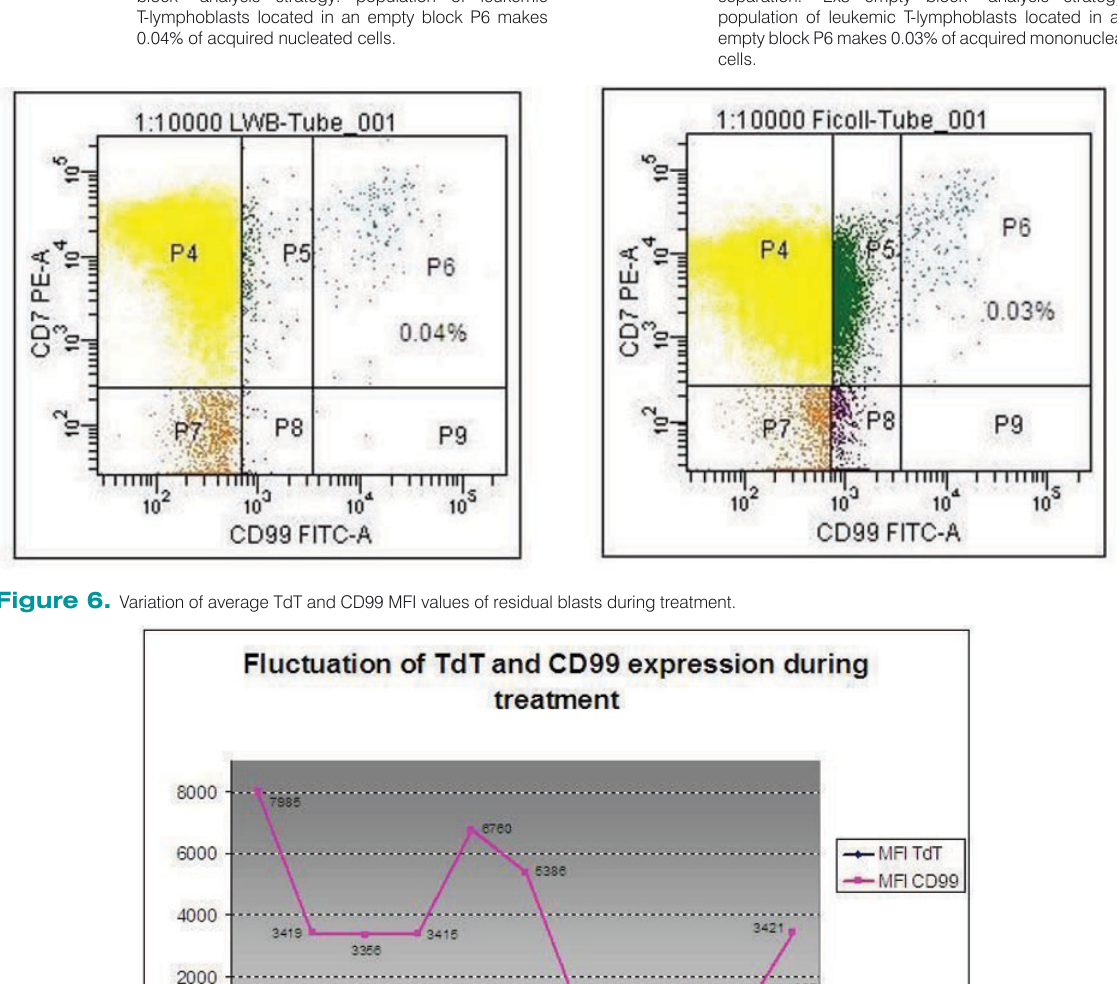
Figure 5a. T-ALL dilution 1:10 000, lysed whole blood. “2x3 empty block” analysis strategy: population of leukemic T-lymphoblasts located in an empty block P6 makes 0.04% of acquired nucleated cells.